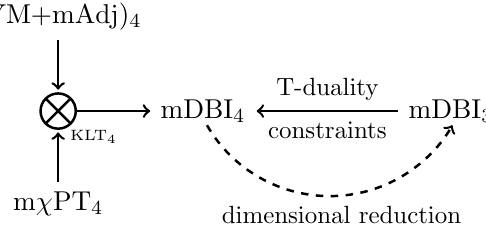
Figure 2 . Overview of calculational approaches to the tree amplitudes in mDBI 4